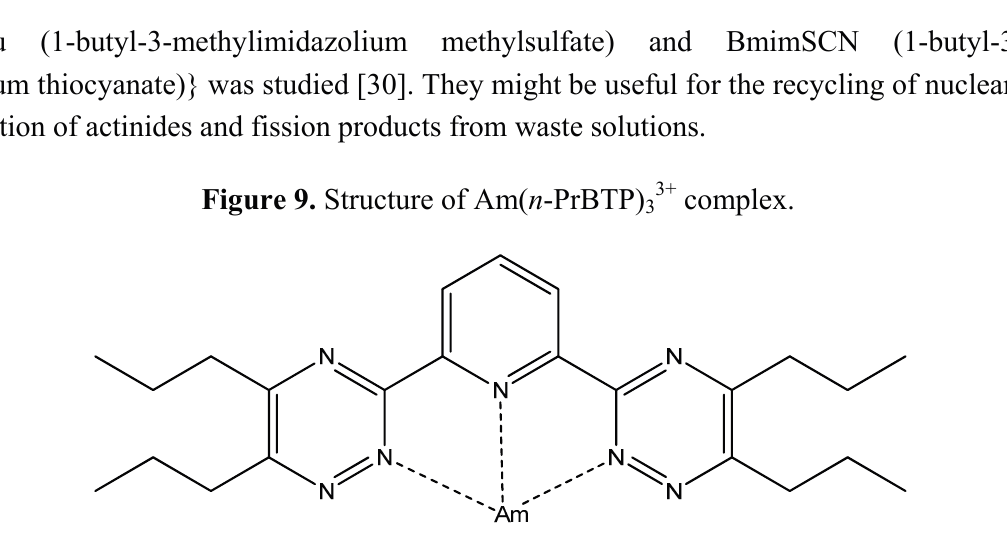
N][U(NCS) (bipy) ]. Selected average bond lengths 4 5 2 = 2.636; N=C=1.166; bipy